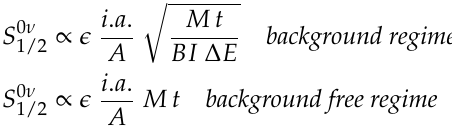
as a function of the exposure and for different 1/2